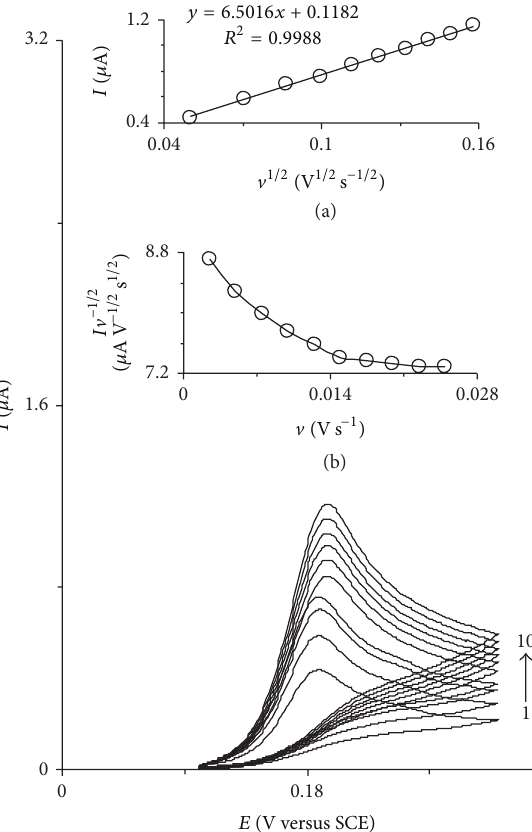
Figure2:CyclicvoltammogramsofHTP-MWCNT-CPEina0.15 M phosphate buffer solution (pH 7.0) containing 0.11mM of codeine at different scan rates. The numbers of 1–10 correspond to scan rates of 2.5, 5, 7.5, 10, 12.5, 15, 17,5, 20, 22.5, and 25 mVs −1 . Insets: (a) variation of the electrocatalytic peak currents versus the square root of scan rate and (b) variation of the scan rate normalized peak current ( 𝐼 𝑝 V −1/2 ) versus the scan